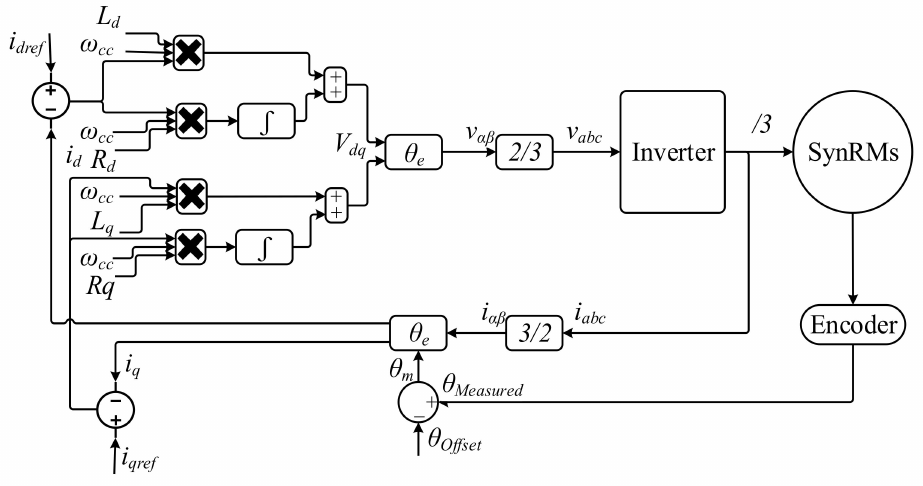
Figure 13. Block diagram of the parameter identification algorithm. Where, L d,q , and R d,q are the inductances and resistances in the d, and q axes, respec- tively. ω cc is the current regulator bandwidth. In this method, to remove the encoder offset, a non-zero current was commanded to reference the motor in the d-axis. The error between the instantaneous d-axis current and the reference value was regulated using a proportional regulator. In this test, the q-axis current was a zero value. The d and q-axes voltage commands were generated in the synchronous reference frame. These voltages were then transferred to the stationary reference frame using Park transform. Then, the command voltages were applied to the motor using the inverter. As discussed earlier, the d-axis current corresponded to the flux, and the q-axis current corresponded to the torque in the motor. Hence, the applied voltages were anticipated not to generate any torque in q-axis current in the control and a slight rotation in the motor shaft. The test was